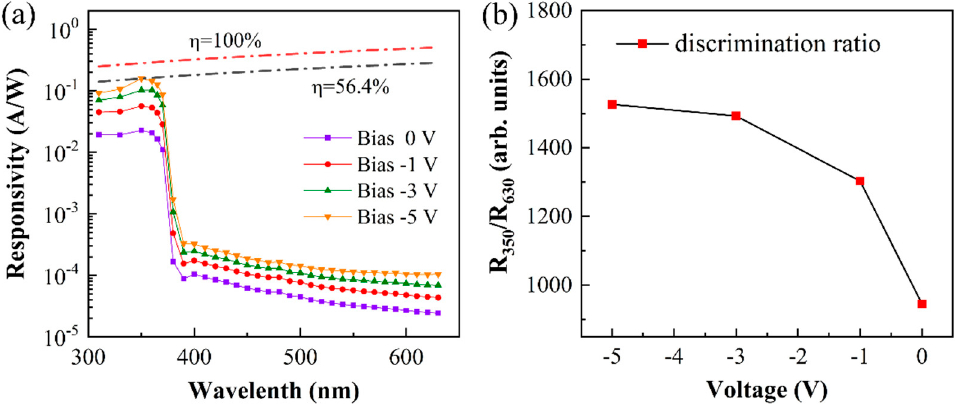
Figure 2. ( a ) Spectral responsivity of detector-A under di ff erent bias voltages. ( b ) Bias voltage Figure 2. (a) Spectral responsivity of detector-A under different bias voltages. ( b ) Bias voltage 141 dependent UV-to-visible (350 / 630 nm) discrimination dependent UV-to-visible (350/630 nm) discrimination ratio. 142 Table 1. A comparison of GaN UV detectors from present study with reports from the literature. 143